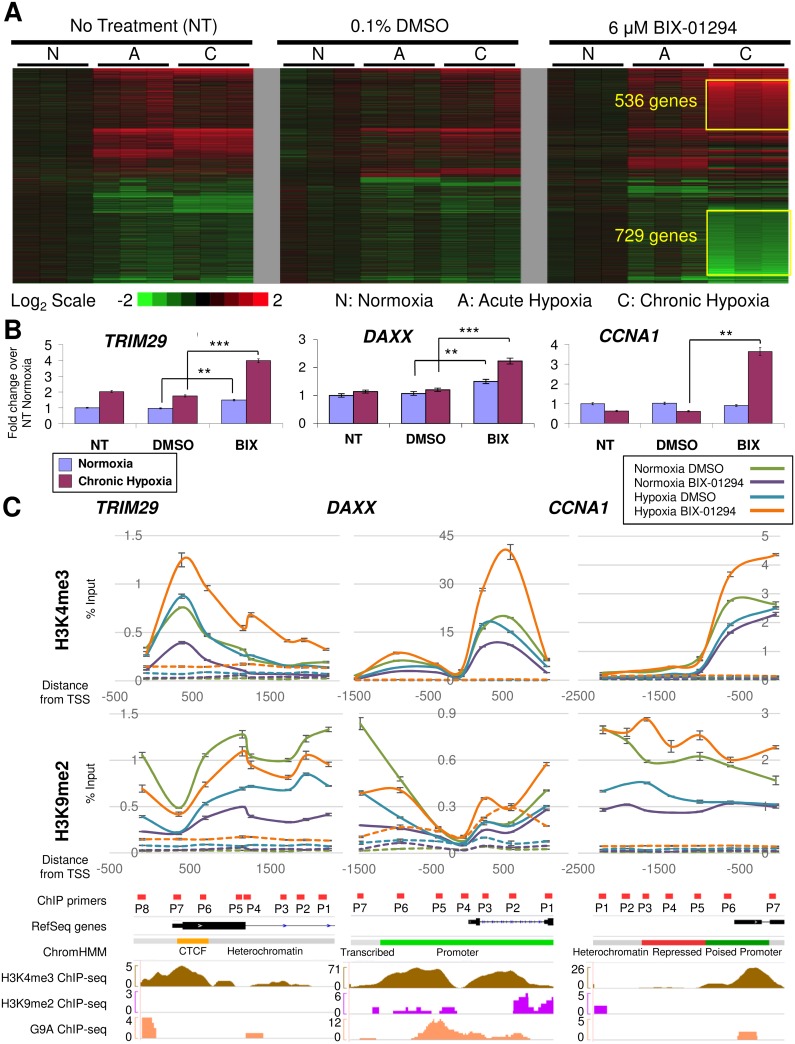
De novo derepression of hypoxia target genes with BIX-01294 and hypoxia treatments.(A) Global heatmap of gene expression changes in MCF-7 cells after 24 hours treatment with 6 μM BIX-01294 compared to the NT and DMSO controls in the indicated conditions (N, normoxia; A, 4 hours acute hypoxia; C, 24 hours chronic hypoxia). Gene expression was compared against the average of the normoxic control for each treatment and filtered for fold changes > 1.5 and P < 0.01. Color bar indicates fold change on a log2 scale in red for upregulation and green for downregulation. Genes that are de novo derepressed only with BIX-01294 and chronic hypoxia are indicated in yellow boxes. (B) Fold change in expression of de novo derepressed genes TRIM29, DAXX and CCNA1 in MCF-7 cells treated with 6 μM BIX-01294 (BIX) compared to the controls (NT and DMSO) in normoxia (blue) and 24 hours chronic hypoxia (magenta). Gene expression levels were normalized against the housekeeping reference gene EEF1G and fold change was calculated against the average of the NT controls in normoxia. Error bars indicate SEM for n = 9 replicates. (C) ChIP-qPCR results showing enrichment of H3K4me3 and H3K9me2 around the TSS of TRIM29, DAXX and CCNA1 in MCF-7 cells treated with 6 μM BIX-01294 in normoxia (purple) and 24 hours chronic hypoxia (orange) compared to the DMSO controls in normoxia (green) and 24 hours chronic hypoxia (blue). Enrichments were normalized against the input controls. Dotted lines show IgG controls for the respective treatments. IGV traces indicate location of primers (red rectangles), exons (black rectangles), introns (connecting black lines with blue arrows indicating transcription direction), CTCF, promoter and repressed regions (yellow, green and red rectangles respectively) for each gene.